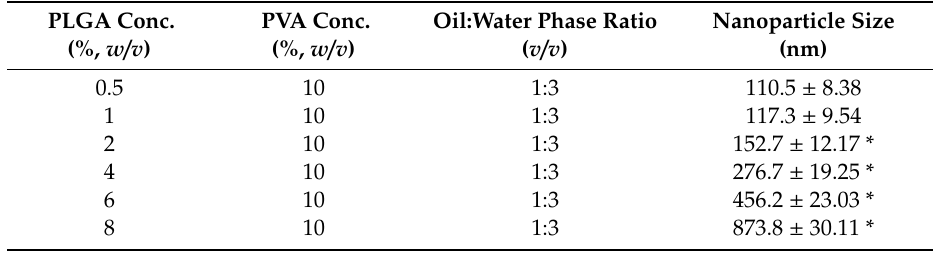
Table 1. E ff ect of poly( d , l -lactide-co-glycolide) (PLGA) concentration on mean particle size ( n = 5, mean ± SD).